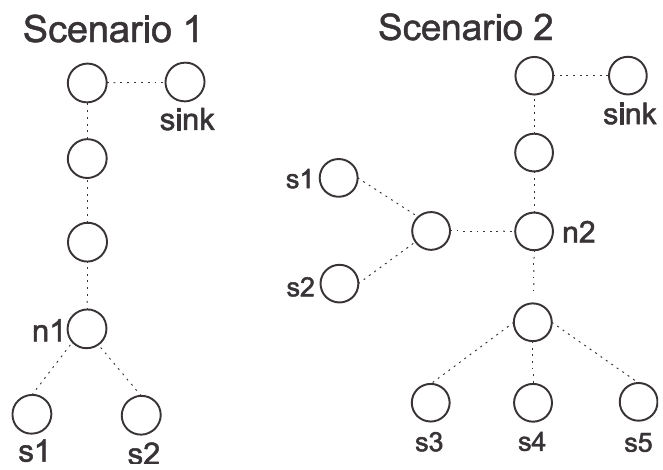
Figure 6. Communication scenarios for the simulations.